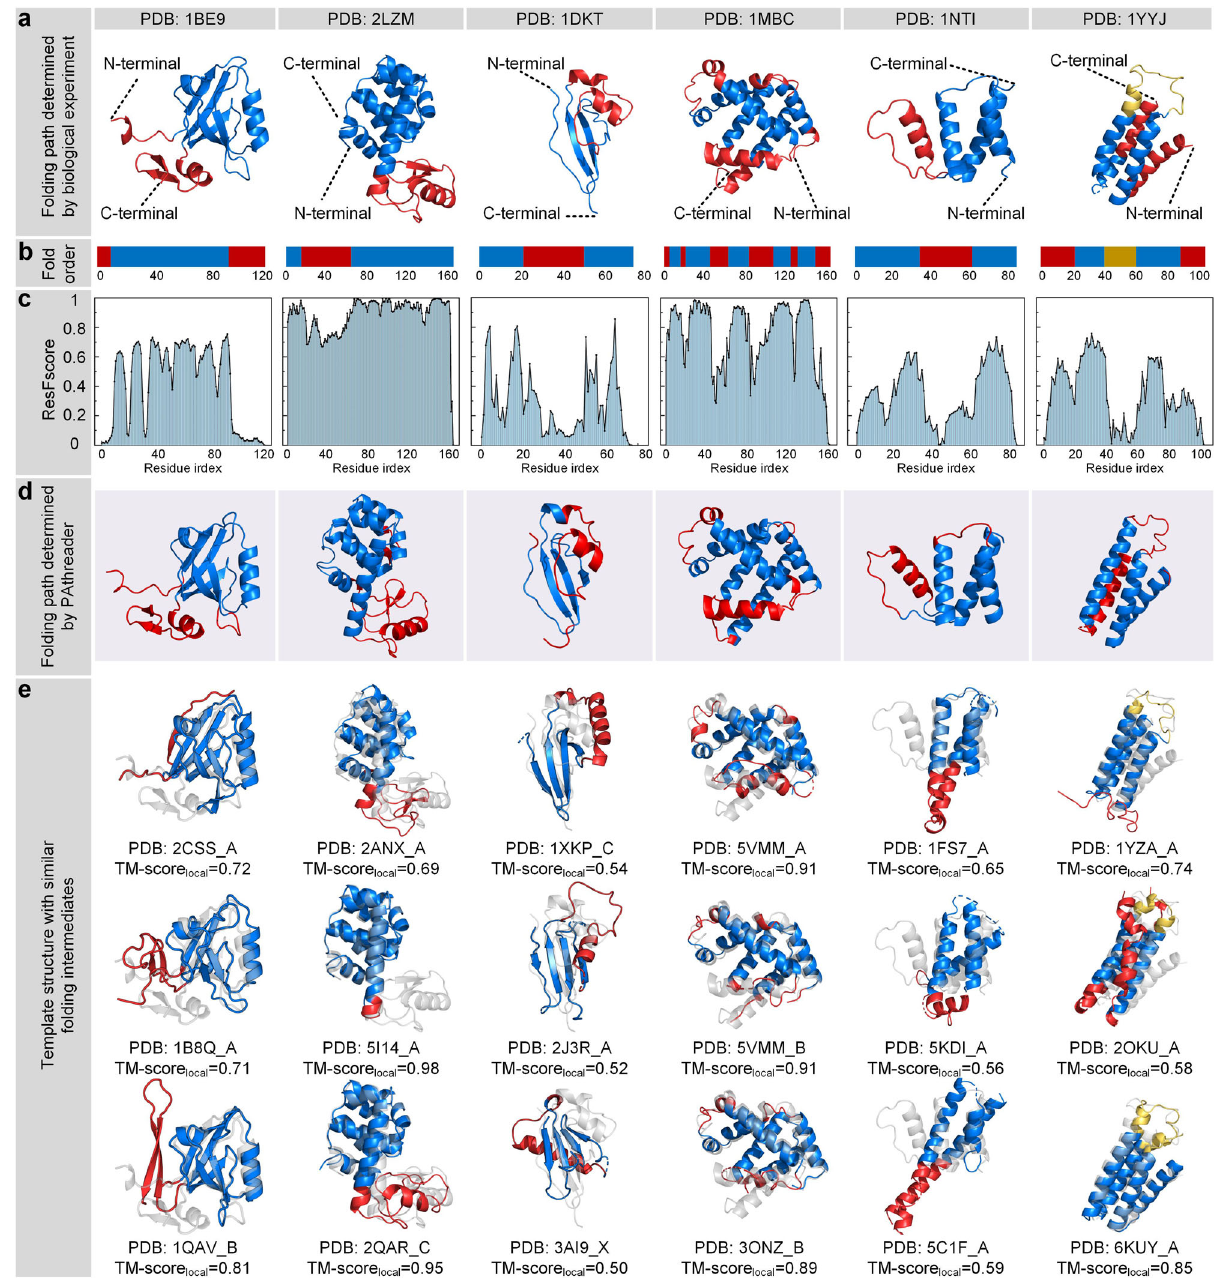
Fig. 6 Results of protein folding pathways. a , b Folding pathway determined by biological experiments. The folding order is blue and then red. c The residue frequency distribution identi fi ed by PAthreader. d Folding pathway determined by PAthreader. e Template structures with folding intermediates (blue) that are similar to those of the target protein (grey). TM-score local is the similarity between the local structure (blue) of the template and the target between protein families. The second important contribution to PAthreader is that DeepMDisPre predicts multiple promising distances for fl exible protein regions (an example is shown in Supplementary Fig. S9), and the three-track alignment uses pre- dicted multi-peak distance pro fi les to optimize the alignment, which allows templates that satisfy all possible distance con- straints to be recognized. The exploration of folding pathways based on remote templates provides new ideas and insights for the study of protein folding mechanisms, which will be advanced by the accumulation of structures deposited in PDB and the rapid expansion of AlphaFold DB.